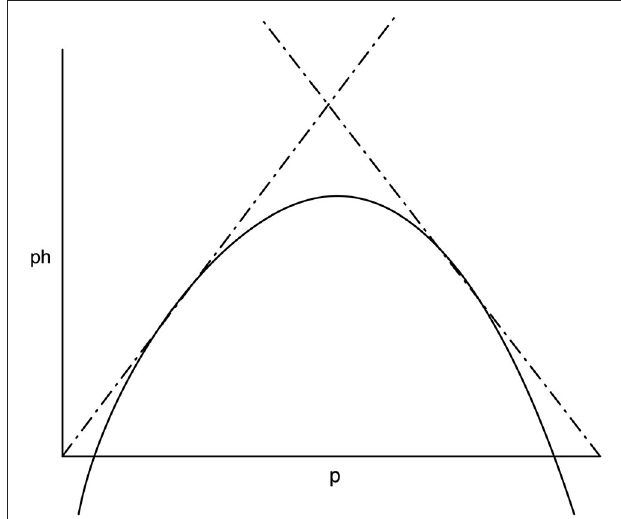
FIGURE 2 | Illustration of the interaction between likelihood and unexpectedness. The overall likelihood (solid) is formed by the multiplication of two monotonic functions: the unexpectedness of a generated item (dashed) and the number of generators likely to agree on it, according to its likelihood